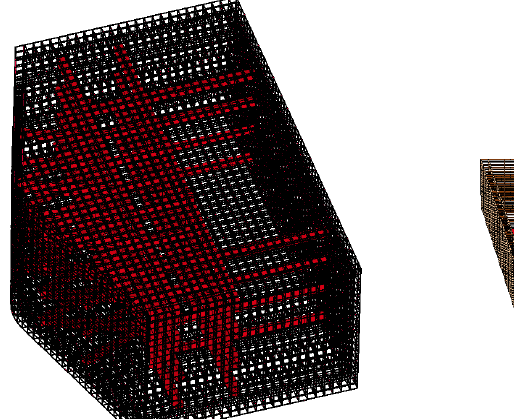
Figure 6. Finite element model of the collision avoidance device.